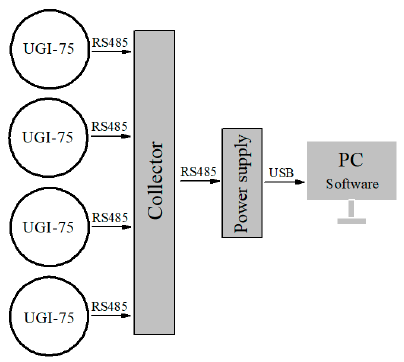
Figure 3. The structural scheme of the complex AMK-03-4.